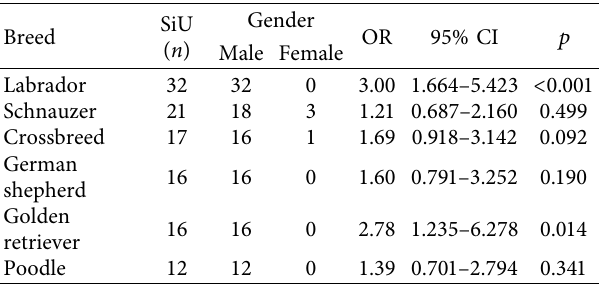
Table 3: Distribution of frequency of silica urolithiasis (SiU) by breed and gender of dogs, and the risk for the breed compared to other breeds without urolithiasis or with another type of